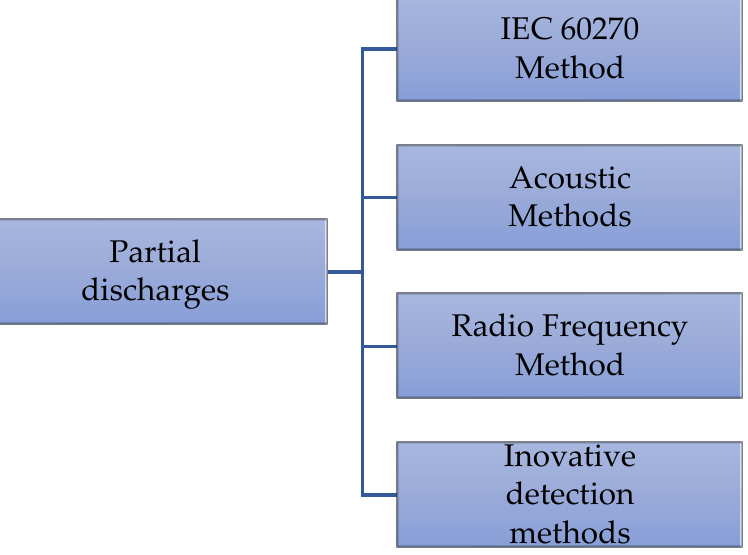
Figure 10. Methods for detecting partial discharges [110].